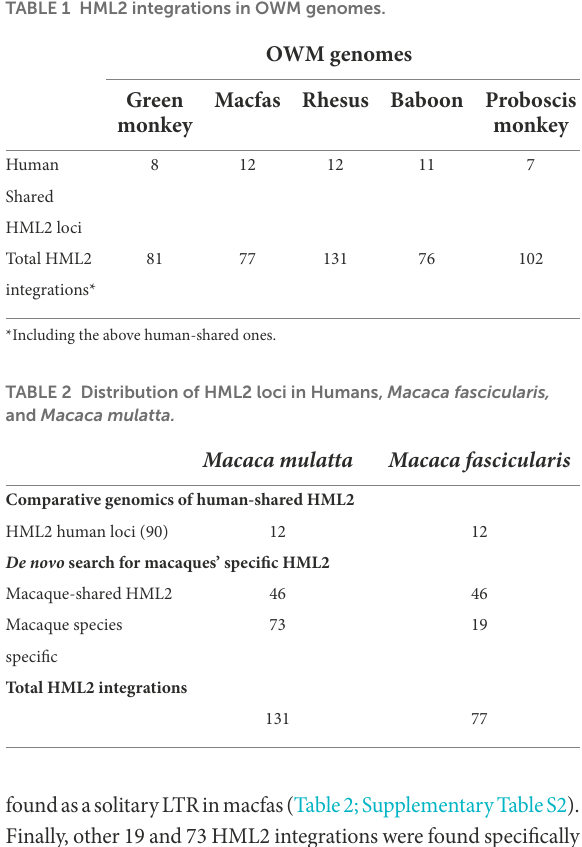
TABLE 1 HML2 integrations in OWM genomes.